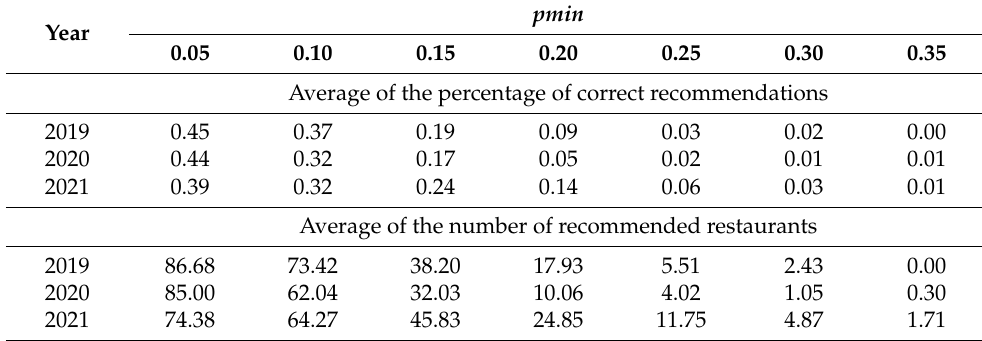
Table 6. Results of matrix factorization according to the value of the parameter pmin